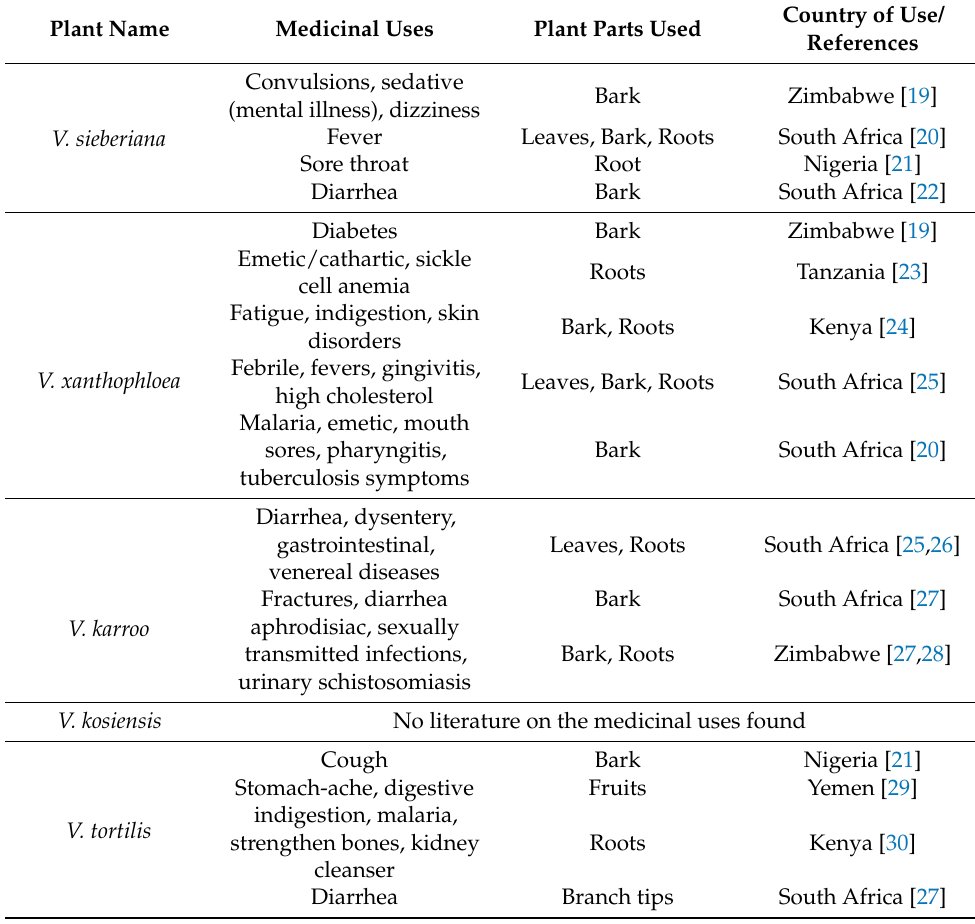
Table 1. Medicinal uses of Vachellia species in African